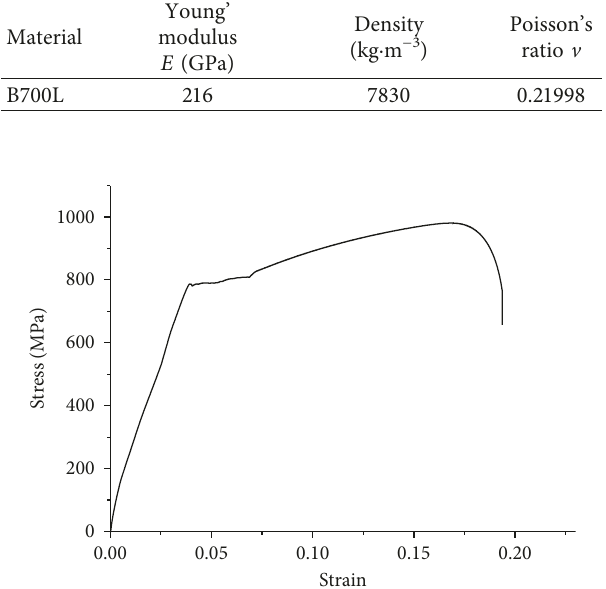
Figure 9: Stress-strain curve of beam high-strength steel